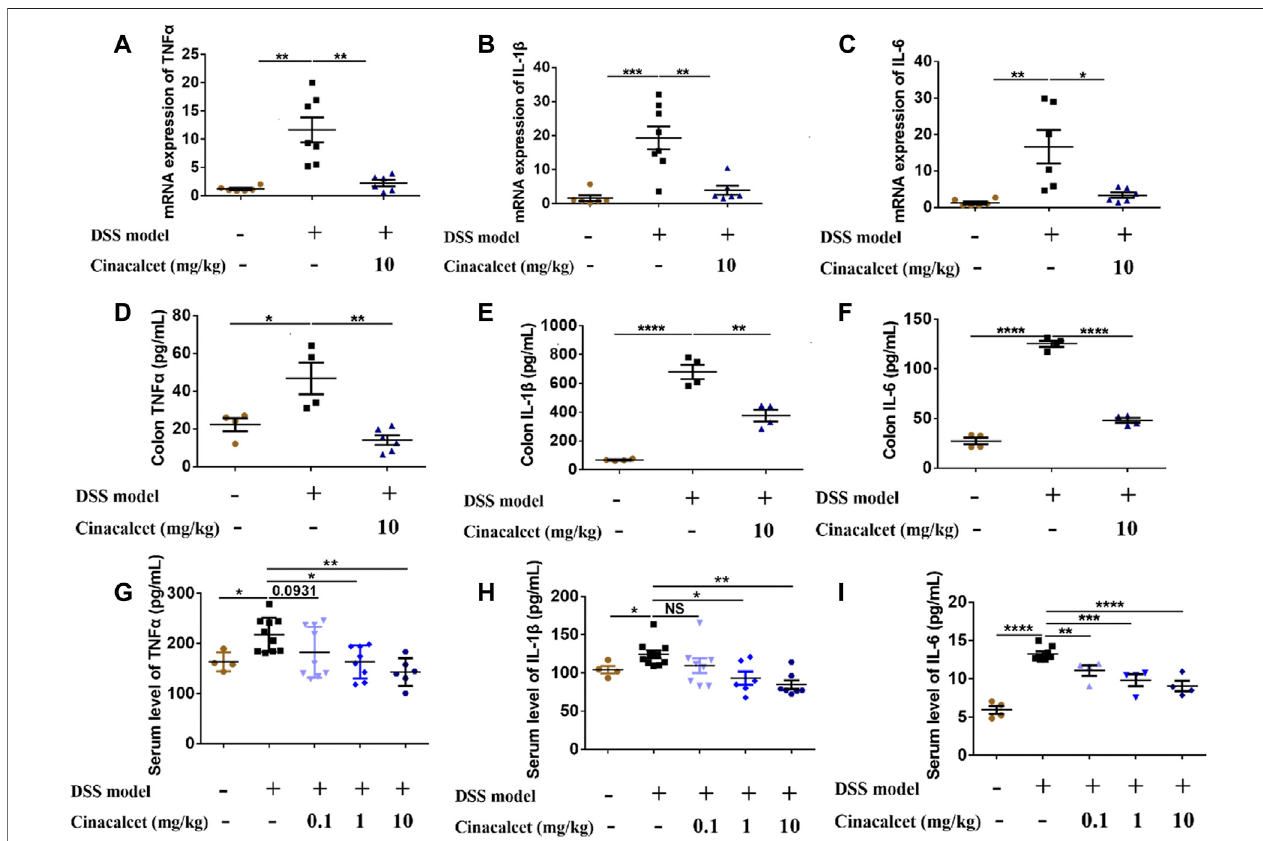
FIGURE 3 | Cinacalcet inhibits in fl ammatory cytokine production in dextran sulfate sodium (DSS)-induced colitis. The expression and secretion of cytokines in cinacalcet-treated mice were tested by qRT-PCR and ELISA. (A – C) mRNA expression levels of IL-1 β , IL-6 , and TNF α in the colon tested by qRT-PCR. (D – F) Secretion levels of IL-1 β , IL-6, and TNF α in the colon detected by ELISA. (G – I) Serum levels of IL-1 β , IL-6, and TNF α detected by ELISA. * p < 0.05, ** p < 0.01, *** p < 0.001, **** p < 0.0001. Data are shown as the mean with standard